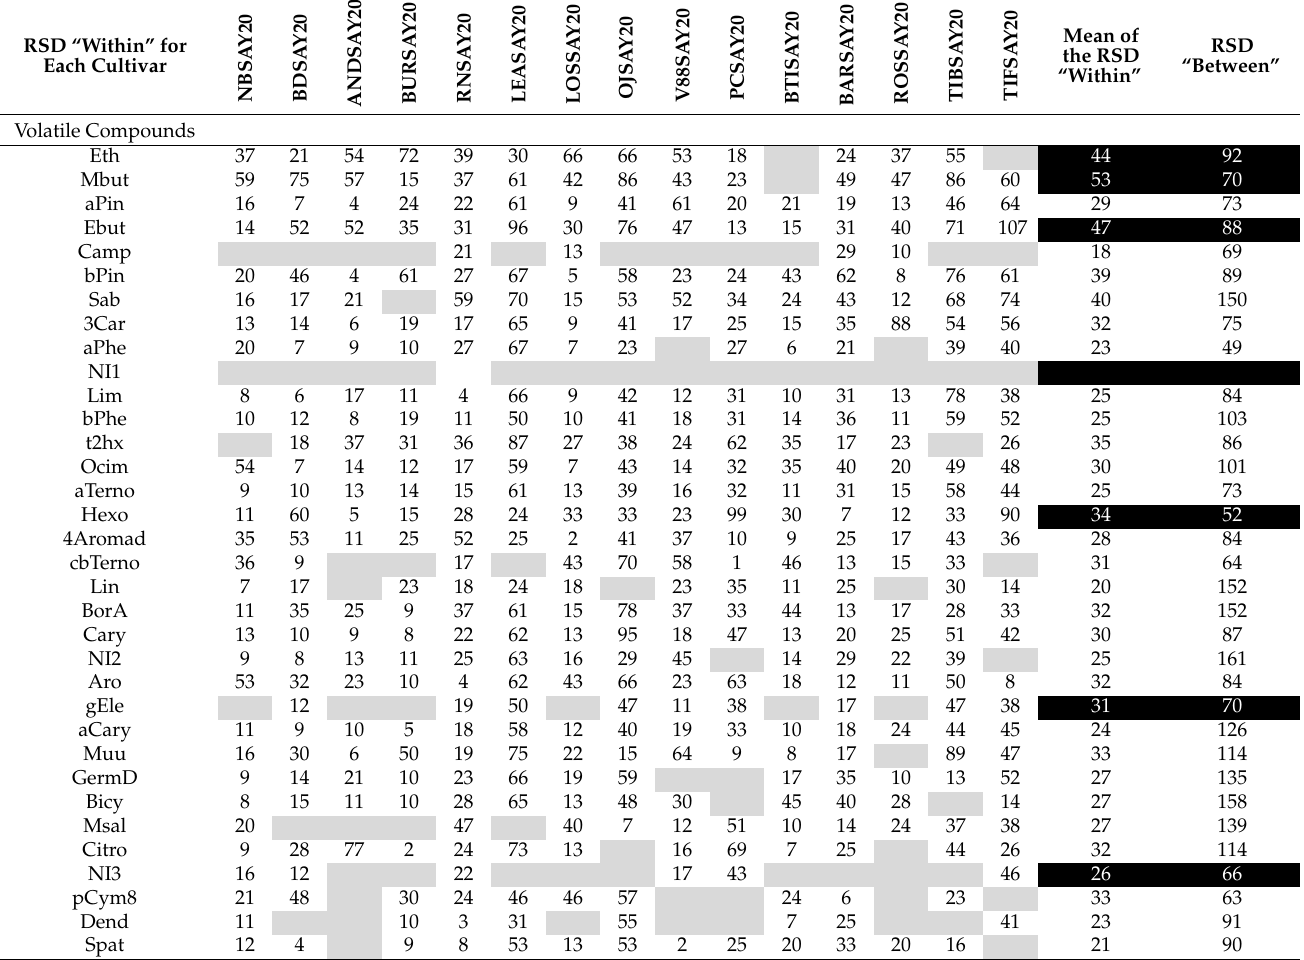
Molecules with means for the RSD “within” and the RSD “between” colored in black were suppressed for the final multivariate data analysis. Cells colored in gray correspond to molecules with abundances below the detection threshold or molecules found only once among the three